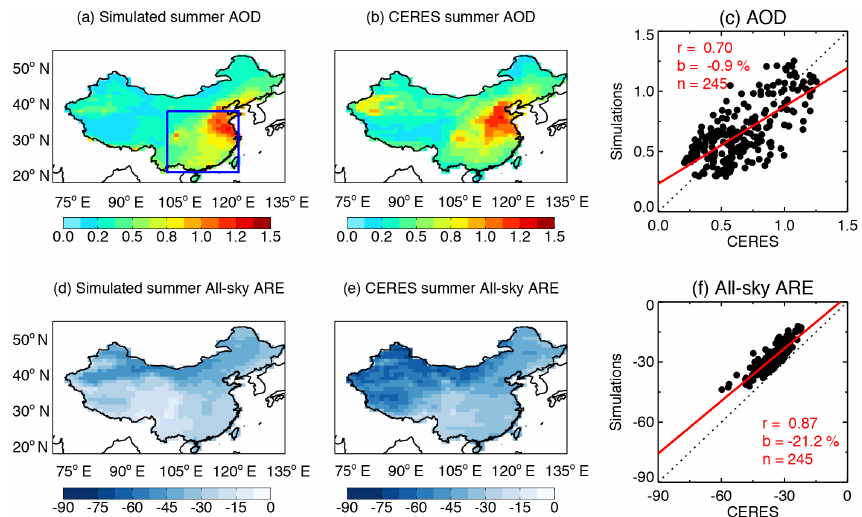
Figure 3. Evaluation of aerosol radiative effects simulated with the CRM. Panels show the simulated (a) AOD at 550nm and (d) all-sky aerosol radiative efficiency (ARE, Wm − 2 per unit AOD) with that from the CERES SYN1deg product ( b , e ). The correlation coefficients ( r ), relative biases ( b ), and number of 1 ◦ × 1 ◦ grid cells ( n ) for the comparisons over the box domain in panel (a) are listed in the scatter plots ( c , f ). The dashed line represents the 1 : 1 ratio. The red line is the linear regression between simulations and data products.